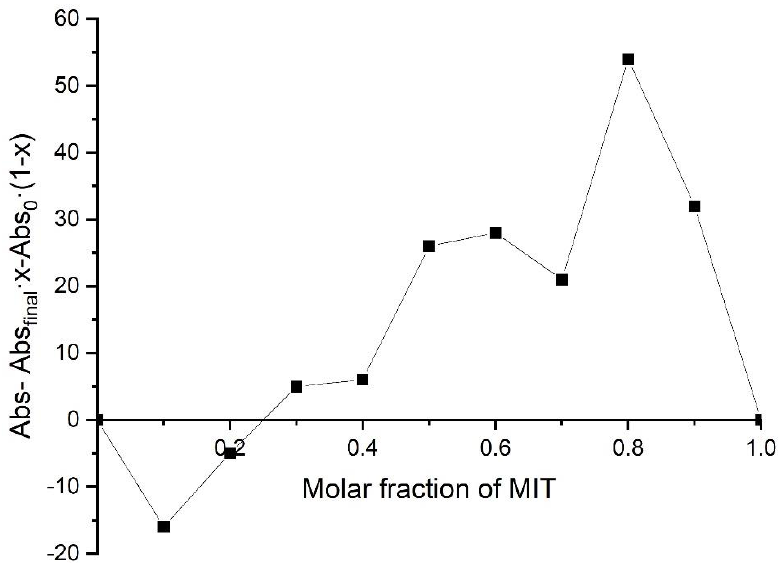
Figure 8. MIT + Fe 3+ JobPlot at pH 5.